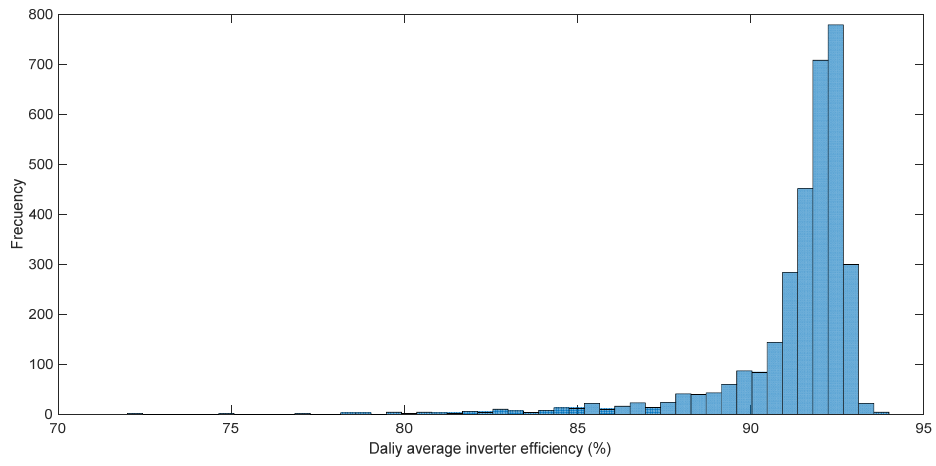
Figure 4. Histogram of daily average values of inverter efficiency over the period 2011–2020.